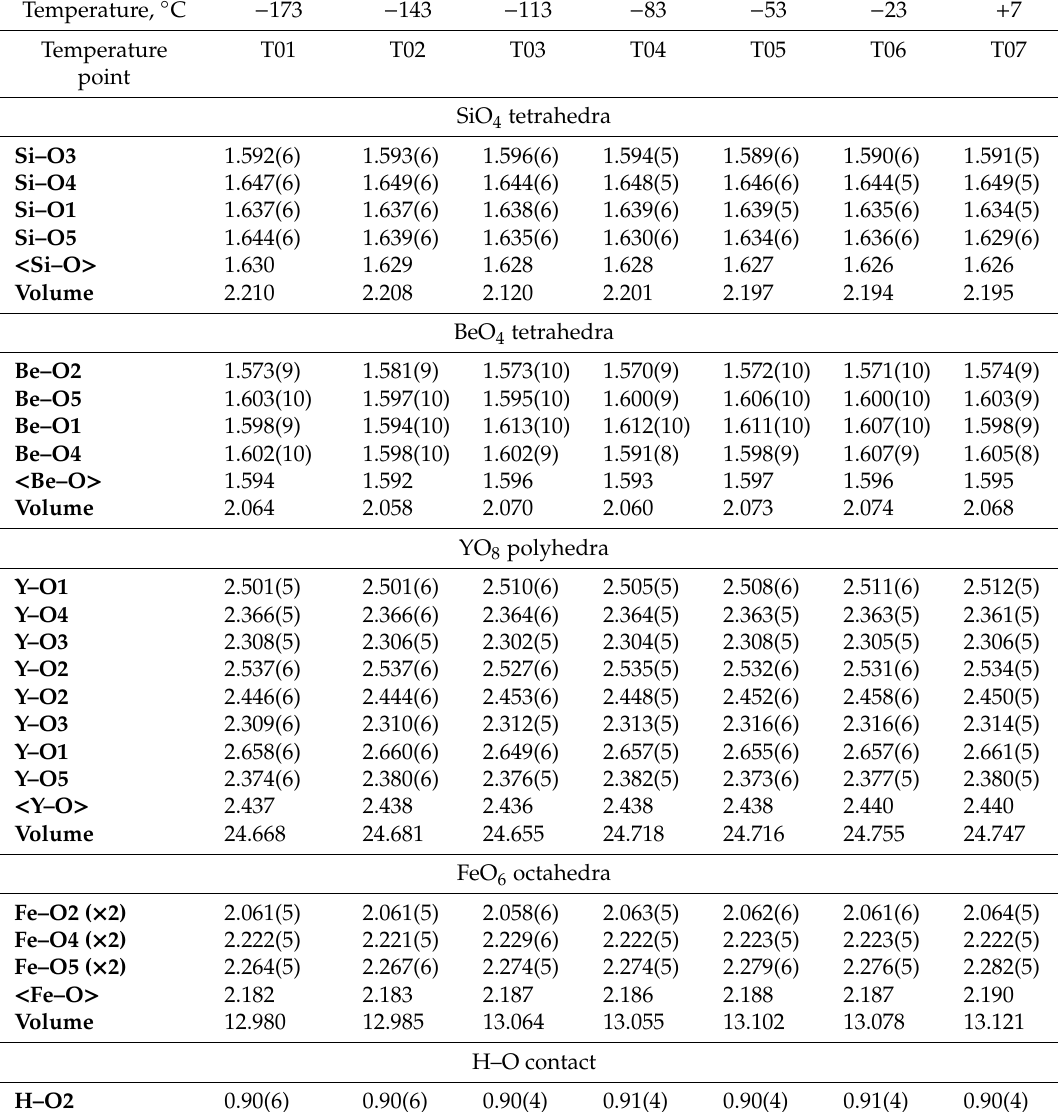
Table 3. Bond distances (Å) and polyhedral volumes (Å 3 ) in the crystal structure of hingganite-(Y). Temperature, ◦